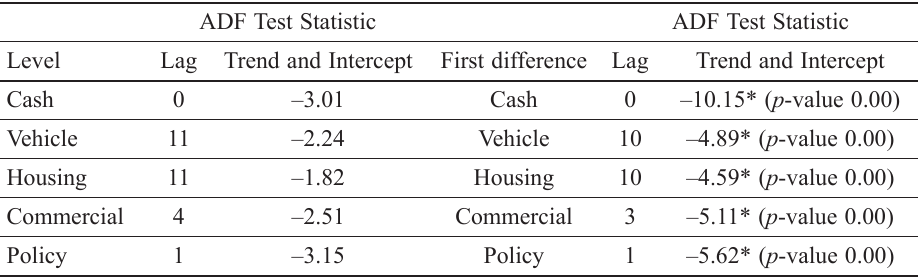
Table 1. ADF test results for all series